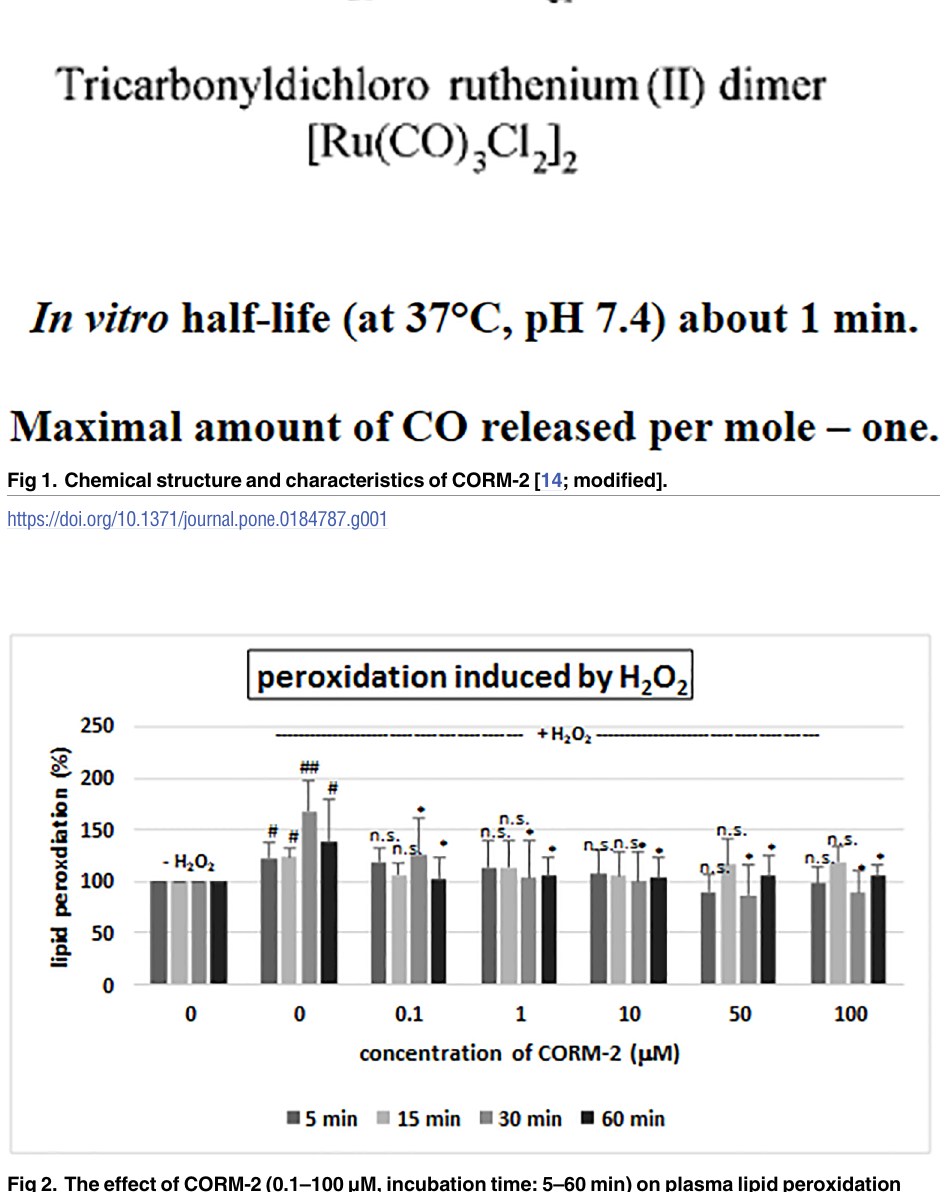
Fig 2. The effect of CORM-2 (0.1–100 μ M, incubation time: 5–60min) on plasma lipid peroxidation induced by H 2 O 2 . Data represents means ± SD of 6 experiments (from different donors). * p < 0.05 vs . control (+ H 2 O 2 ), n.s. p > 0.05 vs . control (+ H 2 O 2 ); # p < 0.05 vs . control (- H 2 O 2 ), ## p < 0.02 vs . control (- H 2 O 2